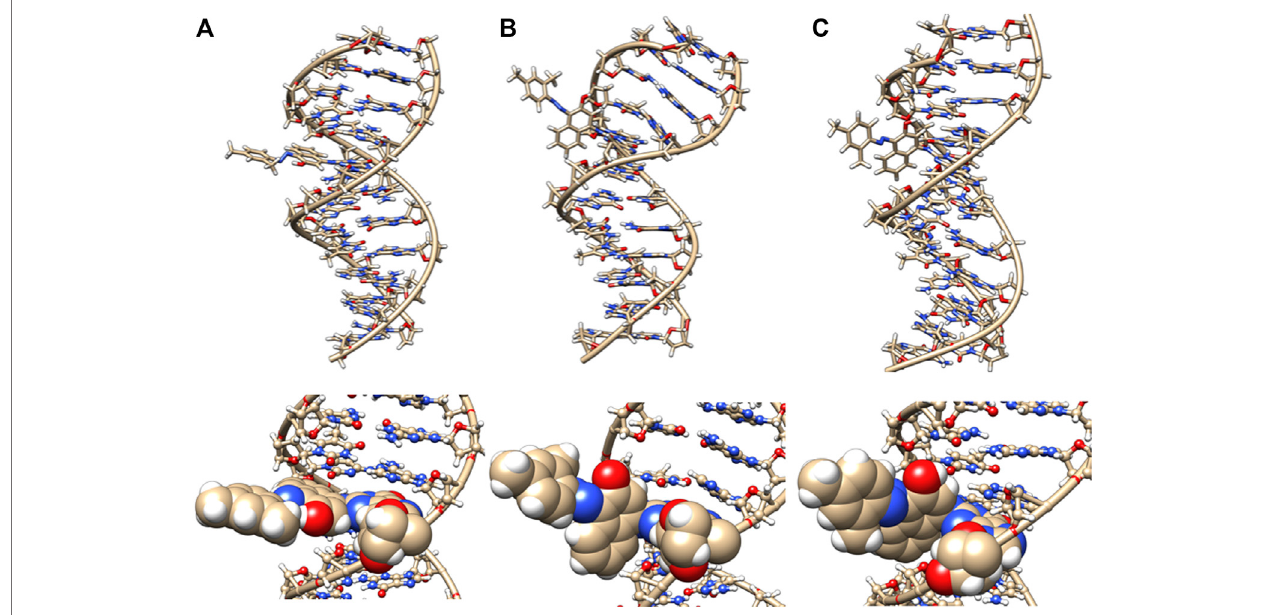
FIGURE9| DNAdodecamerwithSudanIIdyeadduct. (A) Initialminimizedstructure, (B) at100 nsofMDsimulation,and (C) at1µs.Thebottomrowisazoomed- in version of the adduct region.